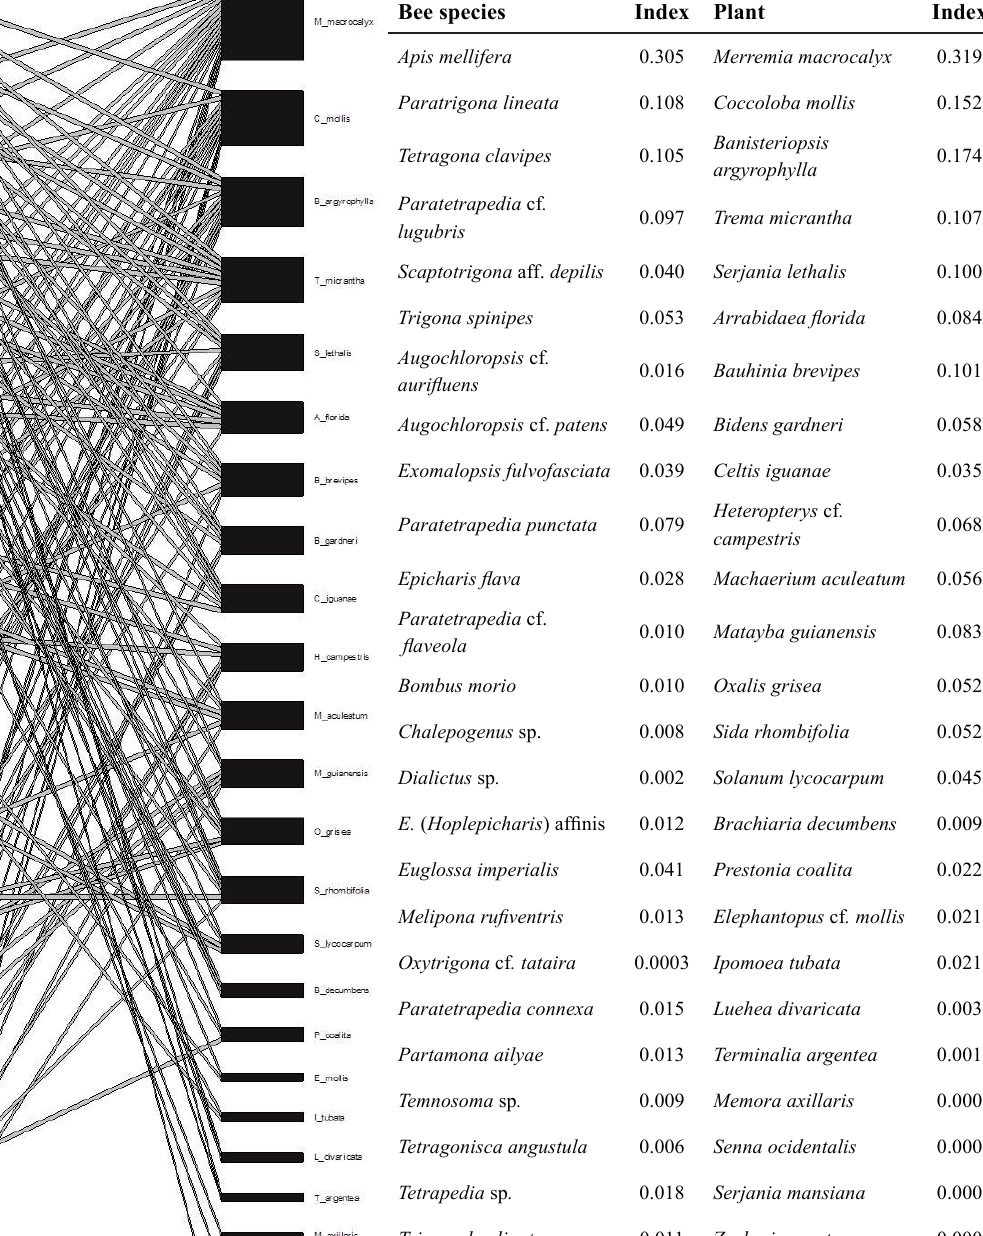
Table 2 . Values of the Betwenness Centrality Index for species of the network of bee-plant interaction sampled in the Semidecidous Forest of “Fazenda São José”, Uberlândia-MG, in 2010 and